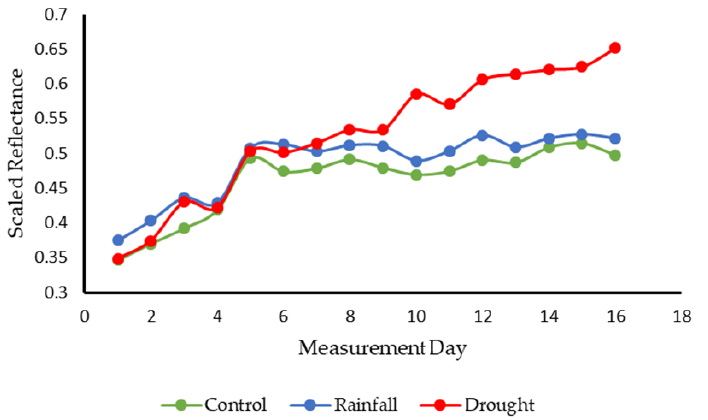
Figure 10. Spectral change observed at 680 nm for each group. Note the continued increase observed in the drought group for the duration of the measurement period. Measurement Day represents days on which measurements were collected rather than a consecutive time period.